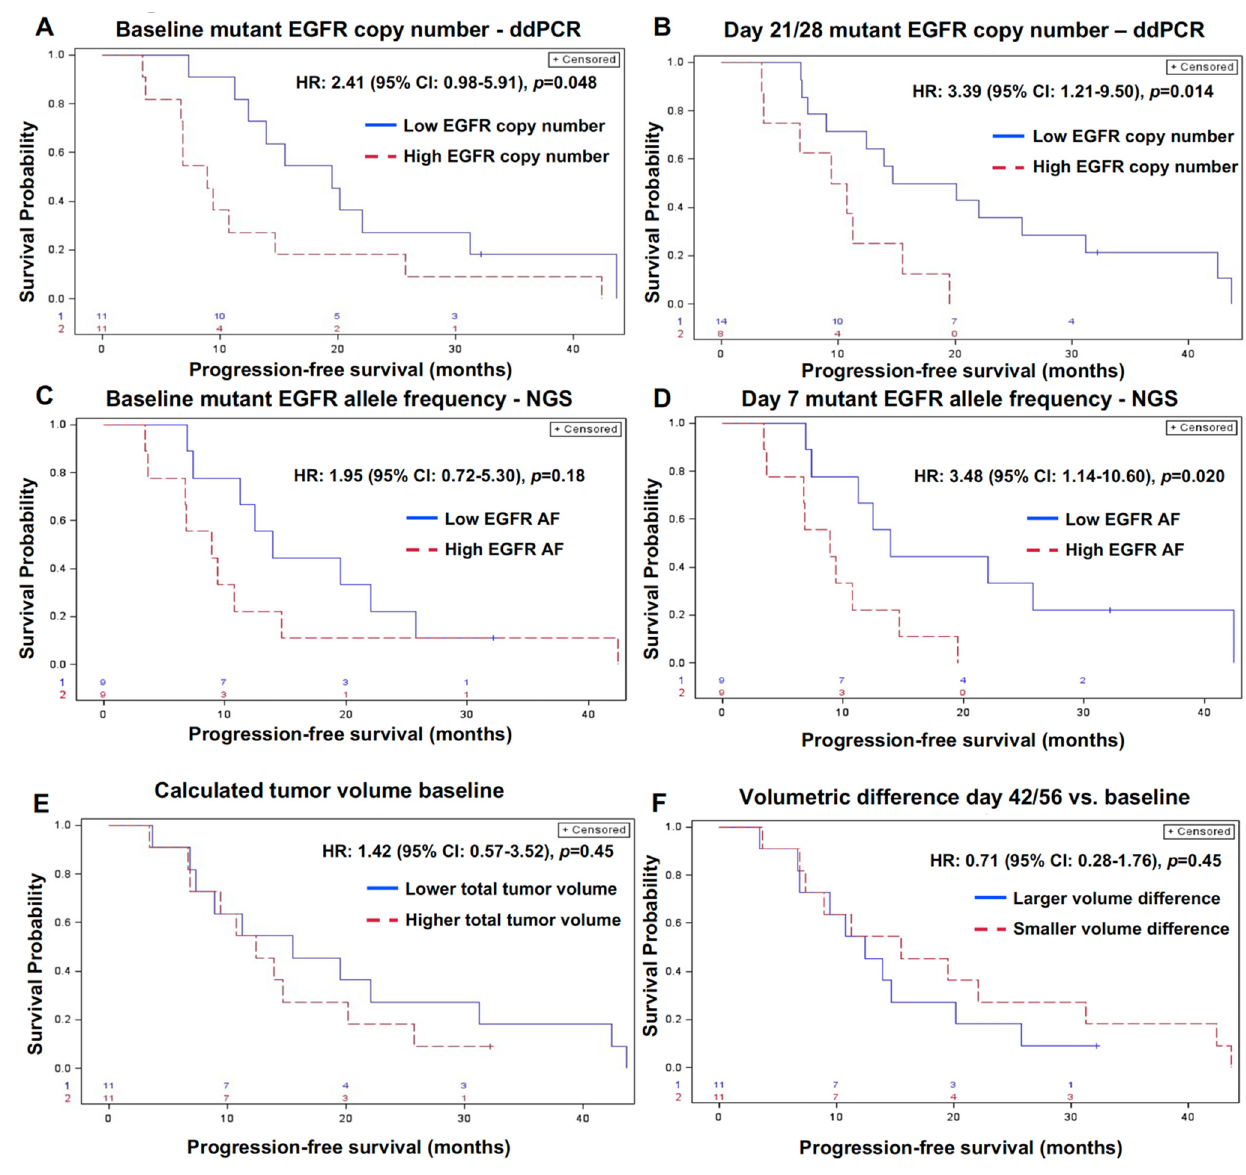
Figure 5. ( A–E ) Progression free survival (PFS) based on the baseline mutant EGFR ctDNA copy number, its clearance on therapy at early time periods on treatment, and baseline tumor volume assessed by volumetric CT. PFS based on mutant EGFR copy number at baseline and on day 21/28 by ddPCR ( A , B ), EGFR AF at baseline and day 7 by NGS ( C , D ), calculated tumor volume at baseline ( E ), and difference in tumor volume between day 42/46 vs. baseline ( F ).